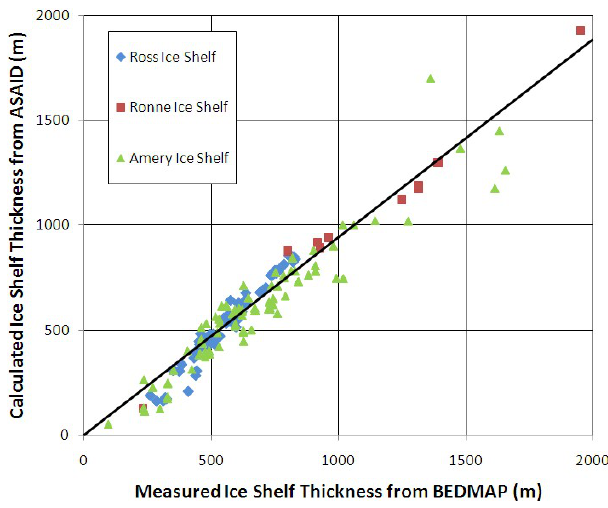
Figure 11. Ice shelf thickness at common points along the ASAID hydrostatic line extracted from BEDMAP mission measurements versus actual ice thickness calculated from ASAID preferred surface elevations (as described in the text). Data symbols distinguish the three ice shelf regions. Sloped line is a linear fit through all points constrained to pass through (0,0) (cf. Table 5).